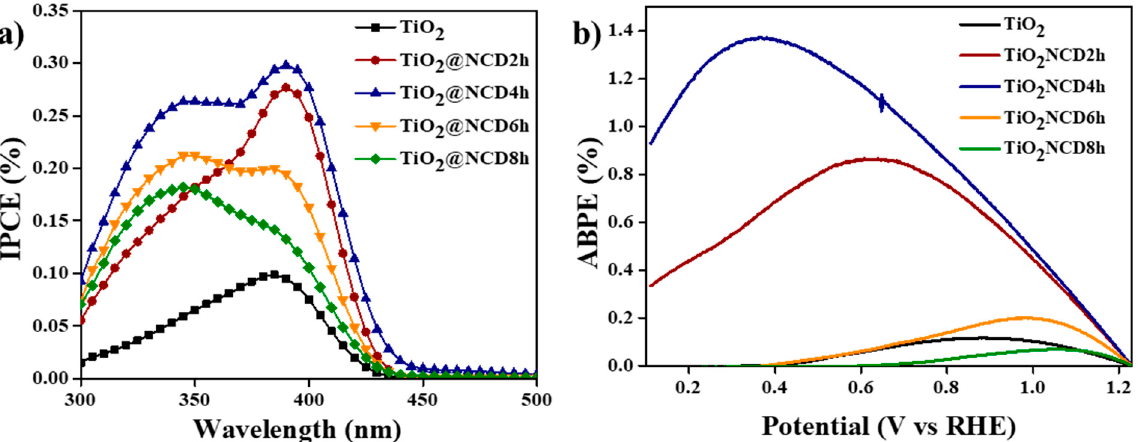
Figure 8. ( a ). Incident photon-to-current conversion efficiency (IPCE) curves; ( b ) Applied bias ABPE of TiO 2 , TiO 2 @NCD2h, TiO 2 @NCD4h, TiO 2 @NCD6h, and TiO 2 @NCD8h measured at 1.23V vs. RHE.